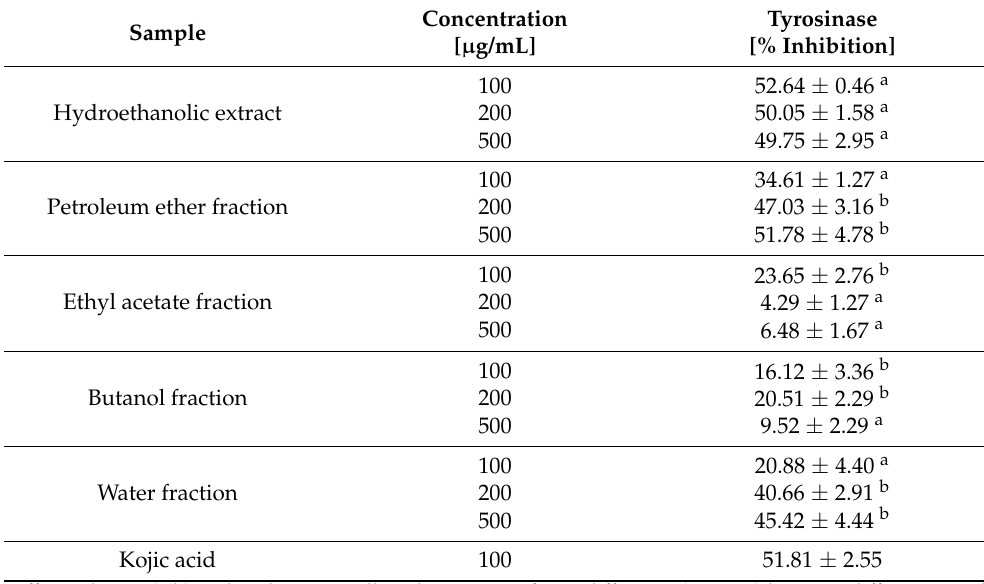
Concentration [ µ g/mL]